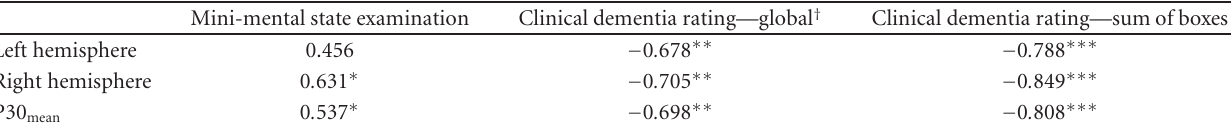
Figure 4: Receiver operating characteristic (ROC) curves for distinguishing (a) controls from MCI and AD, and (b) and AD patients from MCI and control subjects based on TMS-EEG P30. Turquoise line indicates the ROC curve for averaged data, while the grey and black lines indicate ROC curves for the right and left hemisphere, respectively. The area under the ROC curve (AUC) has been given separately for the averaged (P30 mean ) and hemispheric data. The asymptotic significance has been indicated with the null hypothesis of AUC = 0.5 (diagonal line). Table 2: Correlation coe ffi cients (Spearman’s ρ ) between the P30 amplitude and dementia rating